Question: Express in one sentence what the figure is showing.
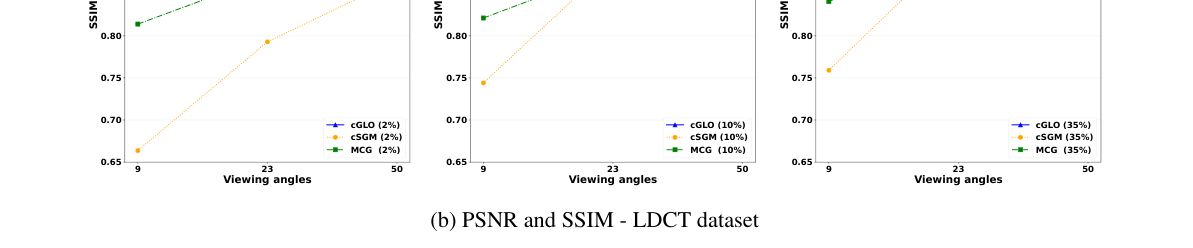
Answer: PSNR and SSIM median values curves corresponding to reconstructions of slices from the LIDC (a) and the LDCT (b) test sets given 9, 23 and 50 experimental viewing angles. Each column is associated with one of the 2%, 10% and 35% training sub-datasets presented in table 1.